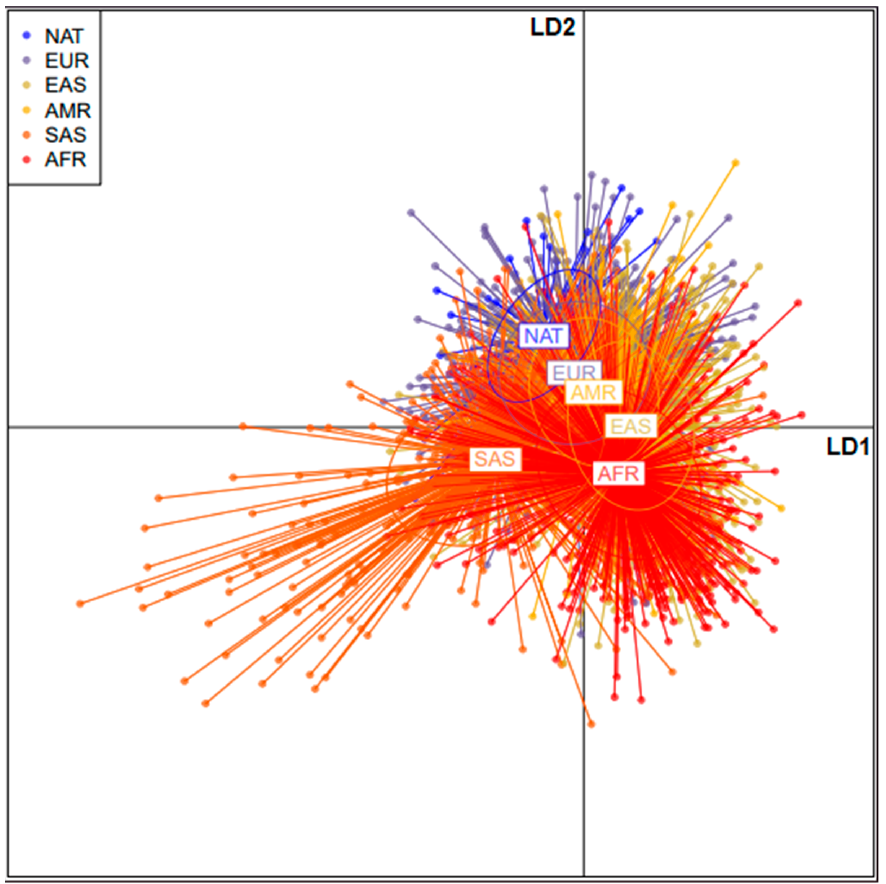
Figure 1. Discriminant analysis of principal components (DAPC) of the analyzed variants in the selected repair genes for Native American populations (NAT), African population (AFR), European population (EUR), American population (AMR), East Asian population (EAS), and South Asian population (SAS).